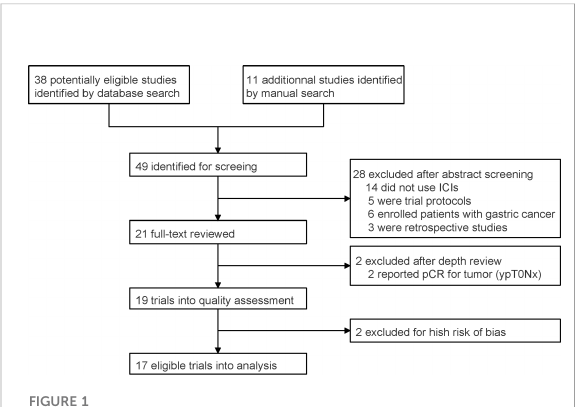
FIGURE 1 PRISMA fl ow chart for prospective trial inclusion. ICI, immune checkpoint inhibitor; pCR, pathologically complete